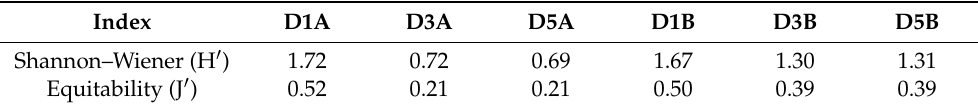
Table 6. Shannon and Equitability indexes of the sequence genera in biofilms of type A and Type B deposits on SSP.